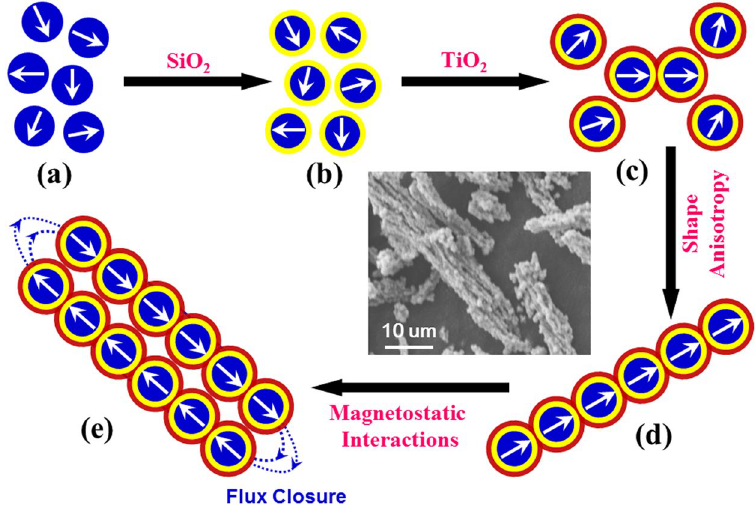
Figure 6. A schematic of the formation mechanism of Fe 3 O 4 @SiO 2 @TiO 2